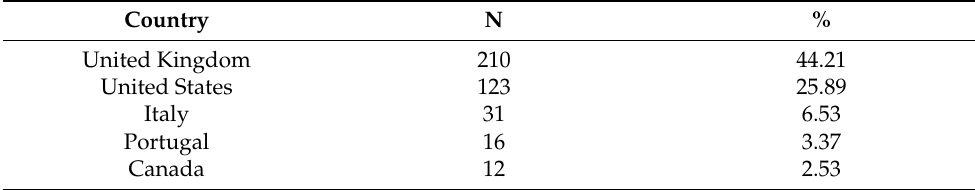
Table 1. Number of documents per country.